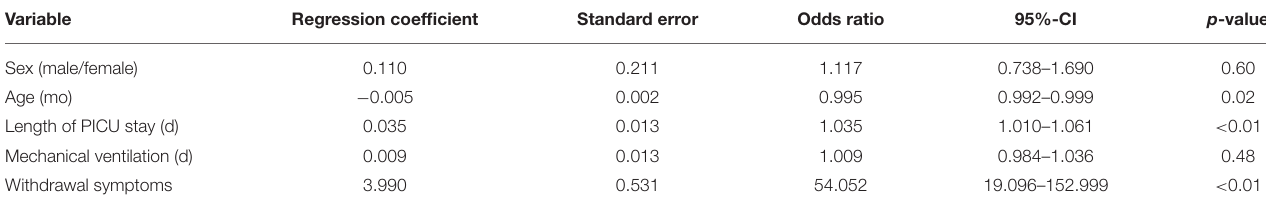
TABLE 5 | Odds ratios for effects of sex, age, length of PICU stay, duration of mechanical ventilation, and withdrawal symptoms on development of delirium. Variable